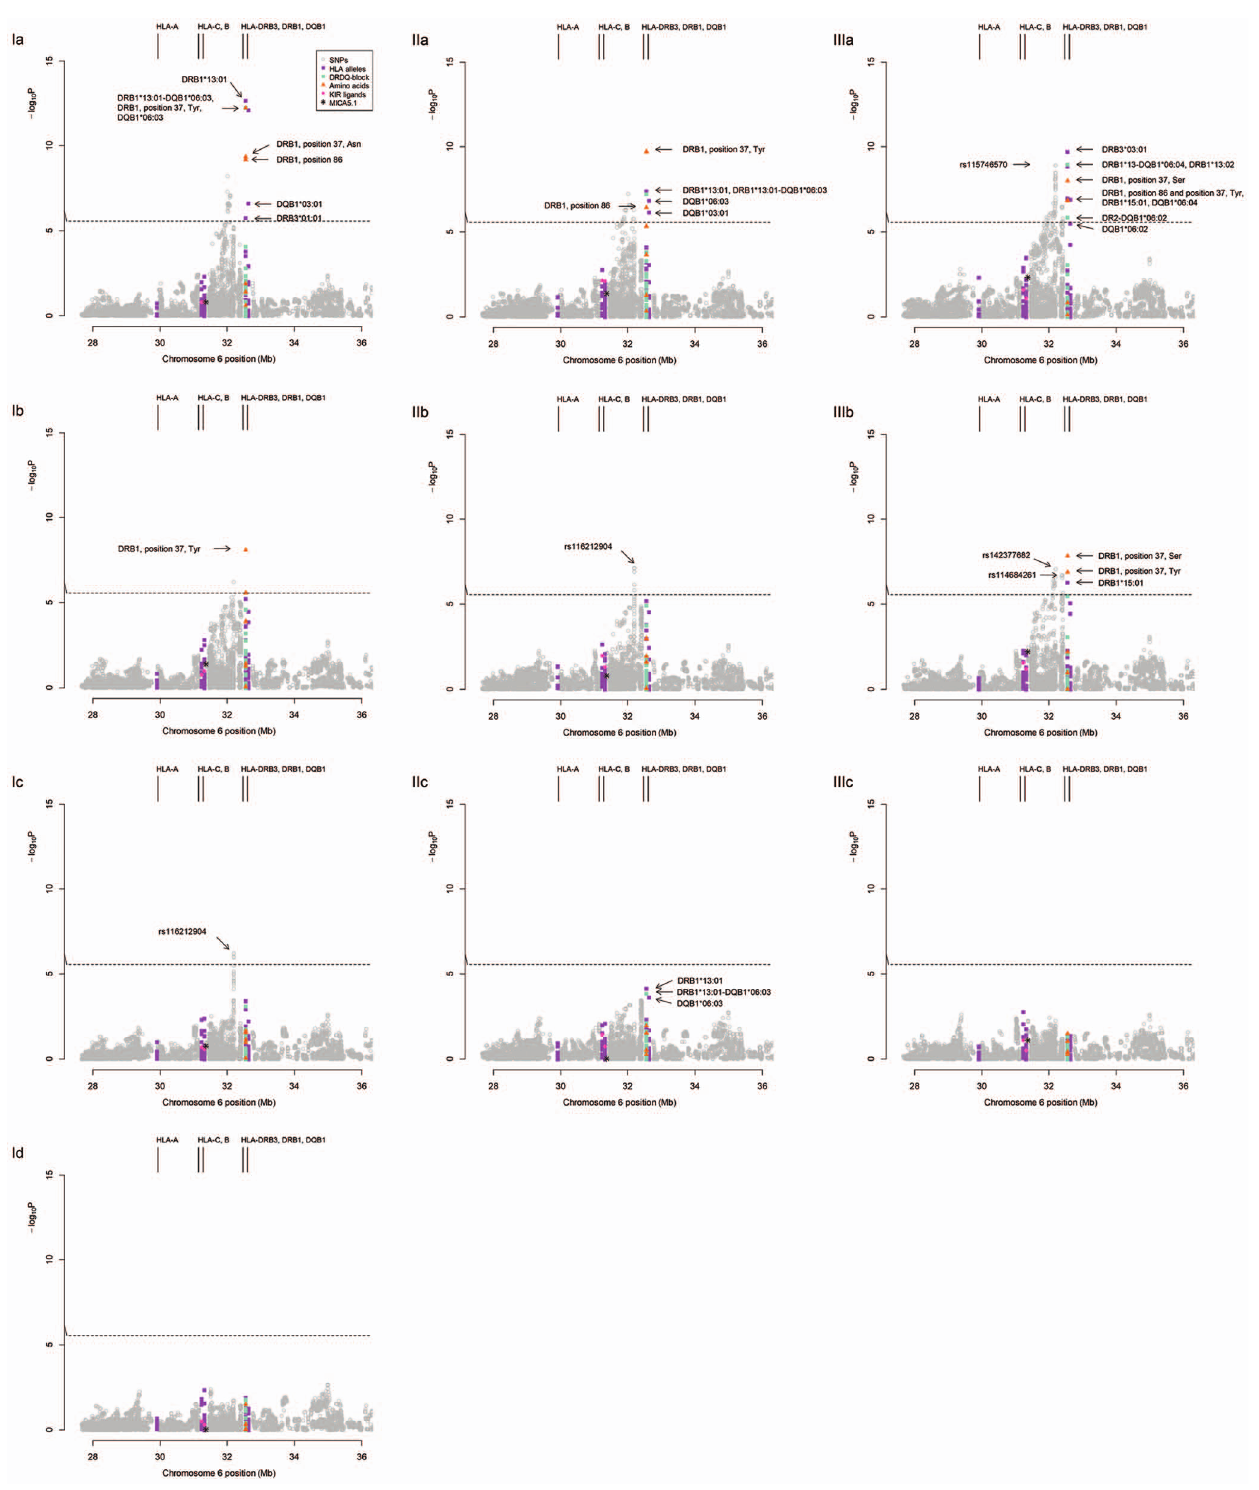
Fig. 2. Conditional logistic regression analyses within the major histocompatibility complex (MHC) in primary sclerosing cholangitis (PSC). The three various conditional strategies employed and their conditional steps are indicated by Ia-Id, IIa-IIc and IIIa-IIIc. For all panels the conditional P -values (y- axis) are plotted against the position on chromosome 6 shown in million base pairs (Mb, x-axis). HLA alleles, DRB1-DQB1 haplotypes, SNPs, the